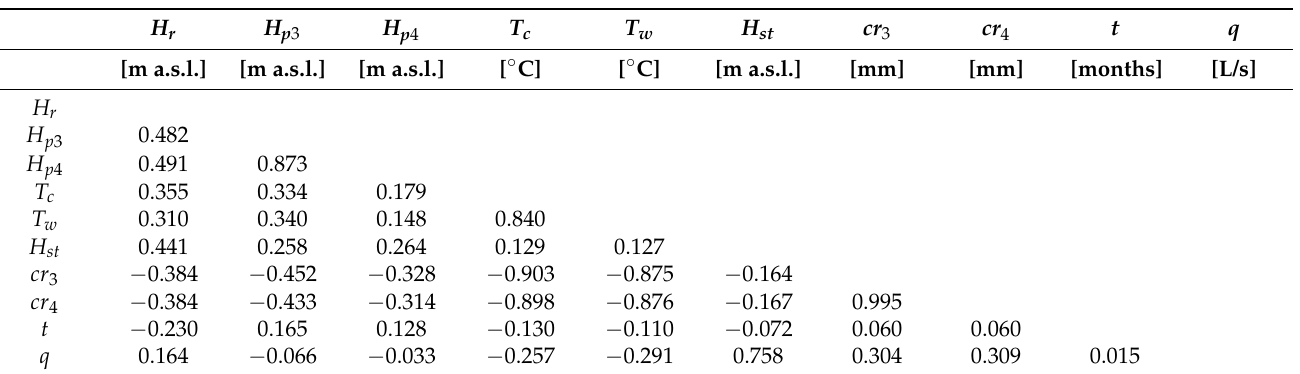
Table 2. Correlation matrix for considered input and output variables for the period